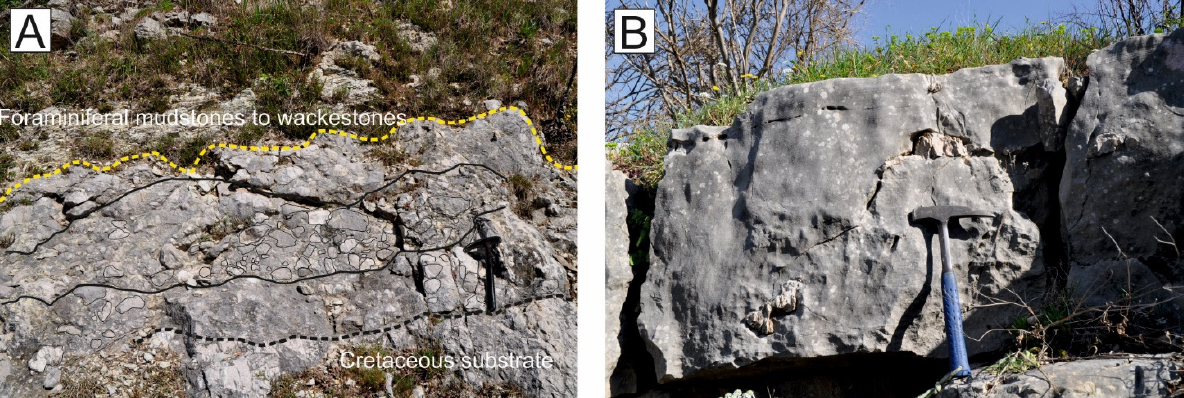
Figure 2. ( A ) Lenses of conglomerates with clasts of Upper Cretaceous platform limestones, clasts of Eocene Scaglia Fm, and clasts of limestones with larger foraminifera lie above the Upper Cretaceous substrate of Southern Western Prenestini (SWP) (Palestrina Castel S. Pietro outcrop); ( B ) in the western portion of the SWP, the Chattian interval is represented by bioclastic calcarenites and calcirudites, rich in larger foraminifera, produced by gravity flows (Palestrina outcrop).